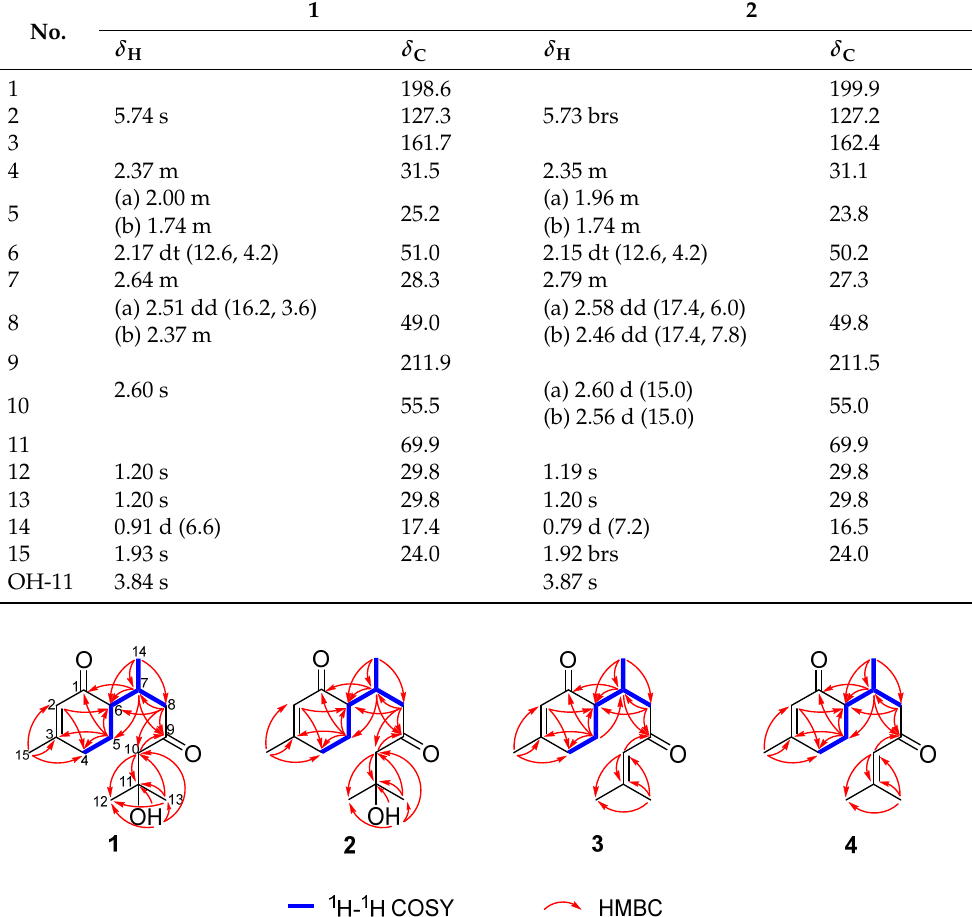
Table 1. 1 H (600 MHz) and 13 C NMR (150 MHz) data for compounds 1 and 2 in acetone- d 6 ( δ in ppm, J in Hz).